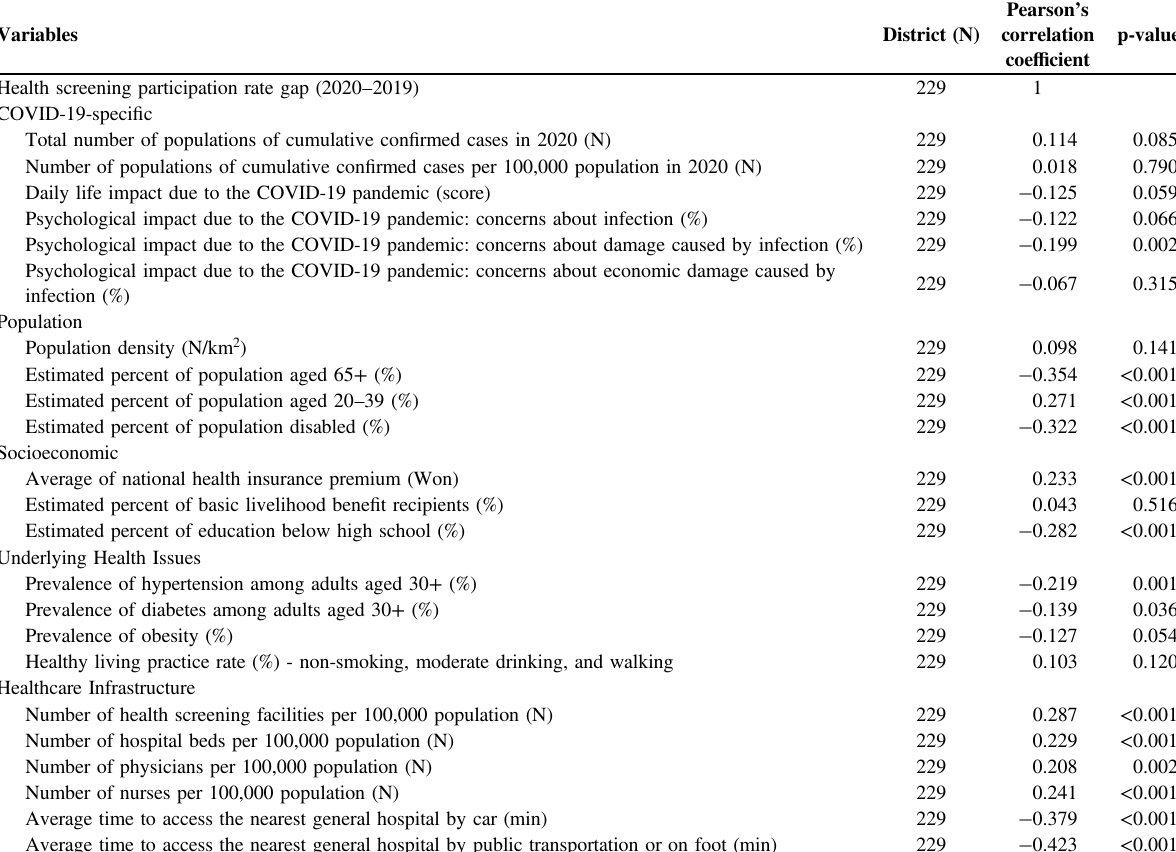
Table 3 Correlations between variables Variables